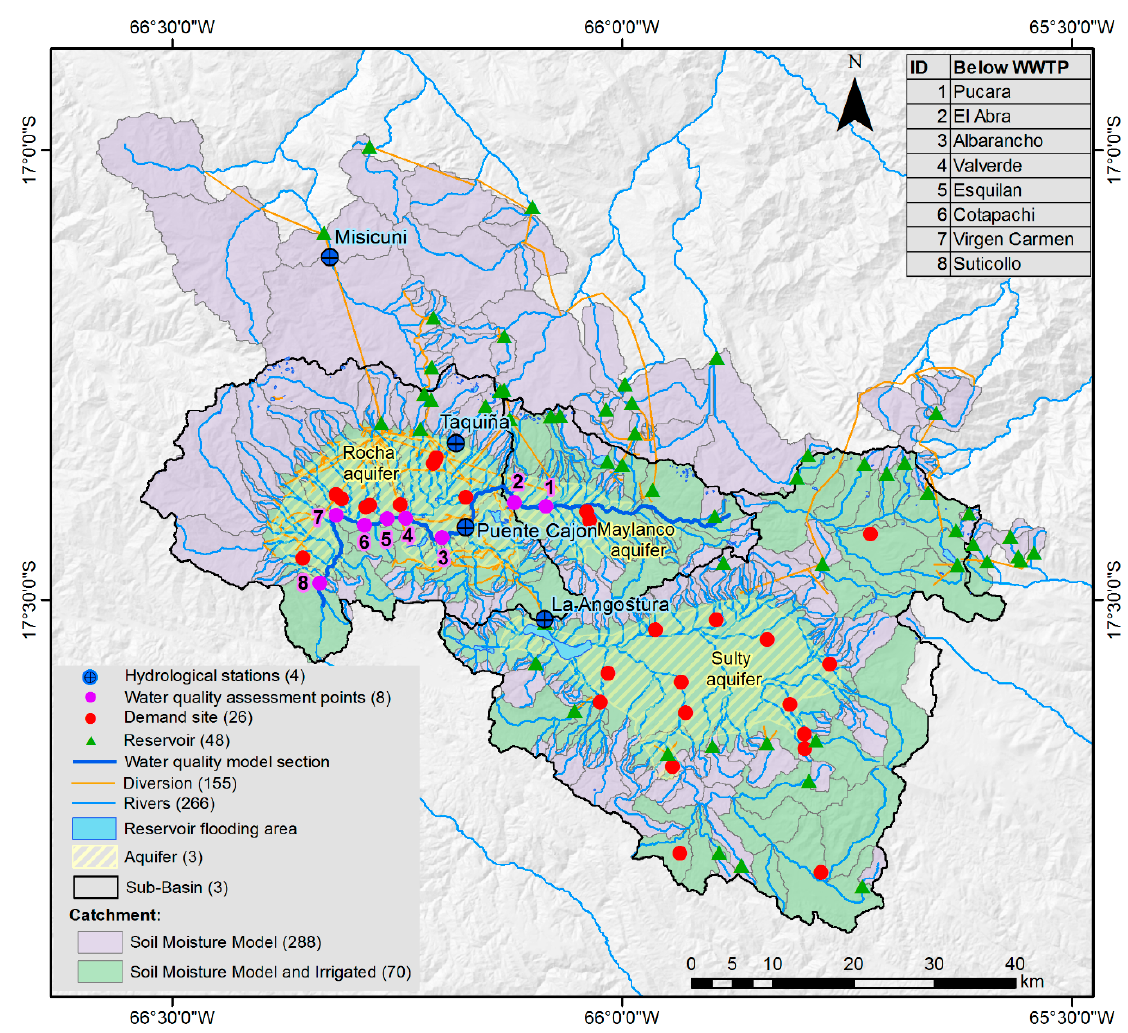
Figure 3. Key components of the Rocha River basin WEAP model. The numbers in parentheses in the legend refer to the number of objects simulated in WEAP.